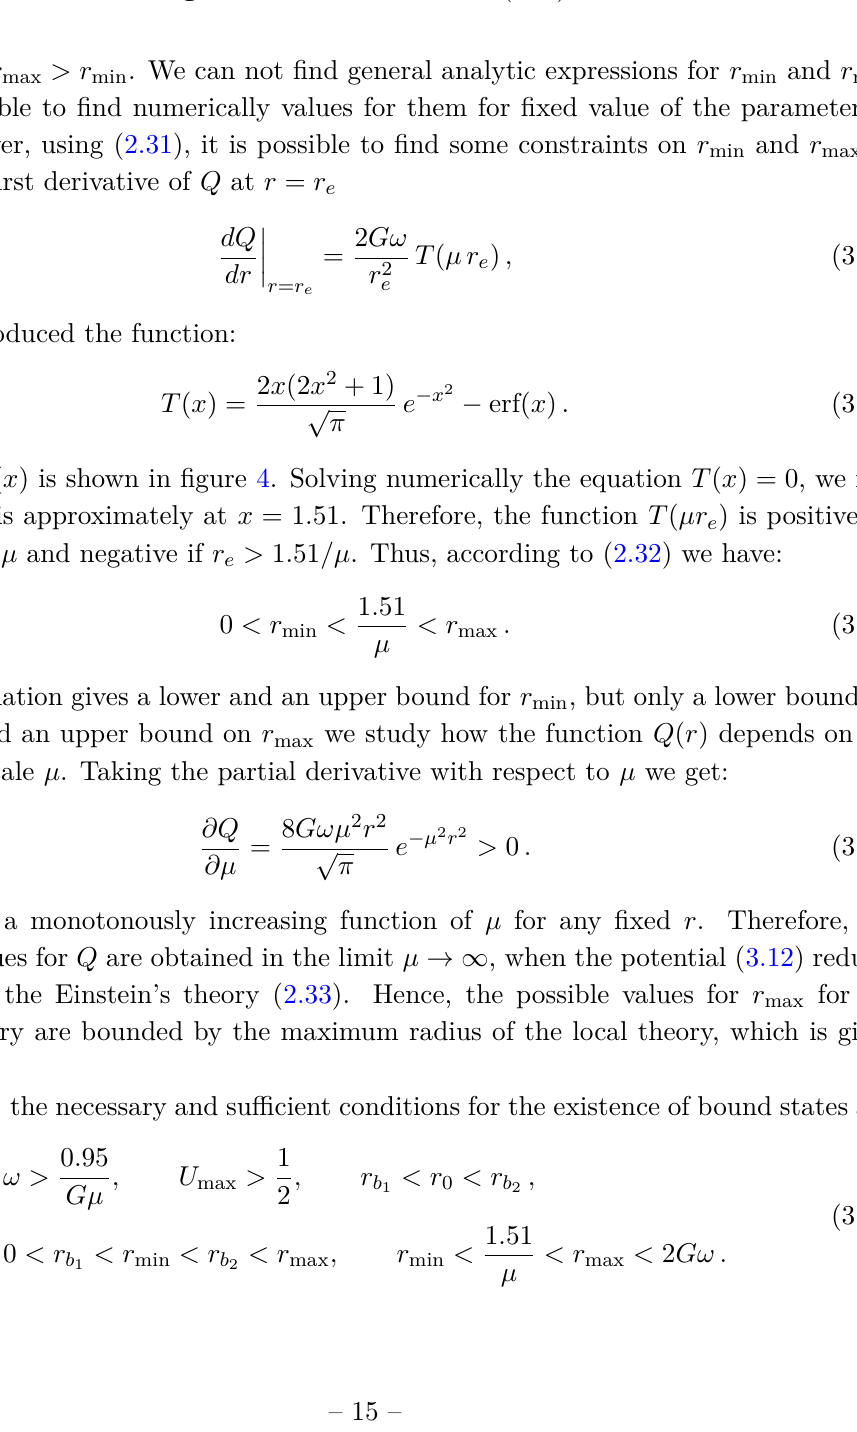
Figure 4 . Plot of the function